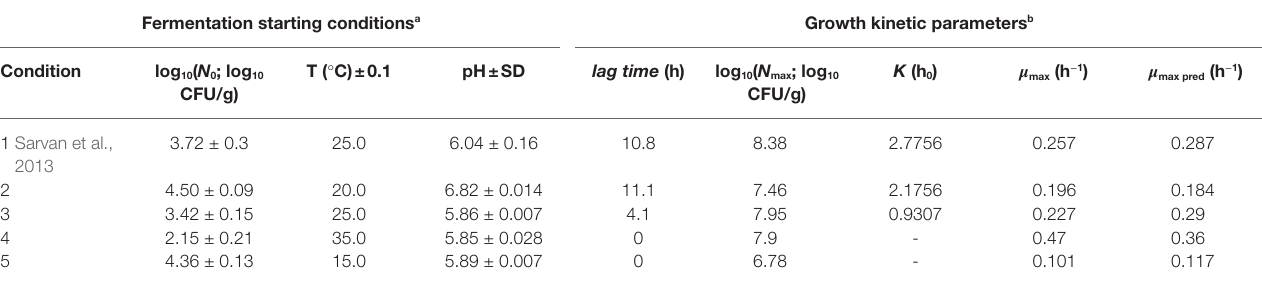
TABLE 1 | Fermentation starting conditions (1–5) and growth kinetic parameters relevant to the growth of Lacticaseibacillus paracasei IMPC2.1 in blanched white cabbage. Fermentation starting conditions a Growth kinetic parameters